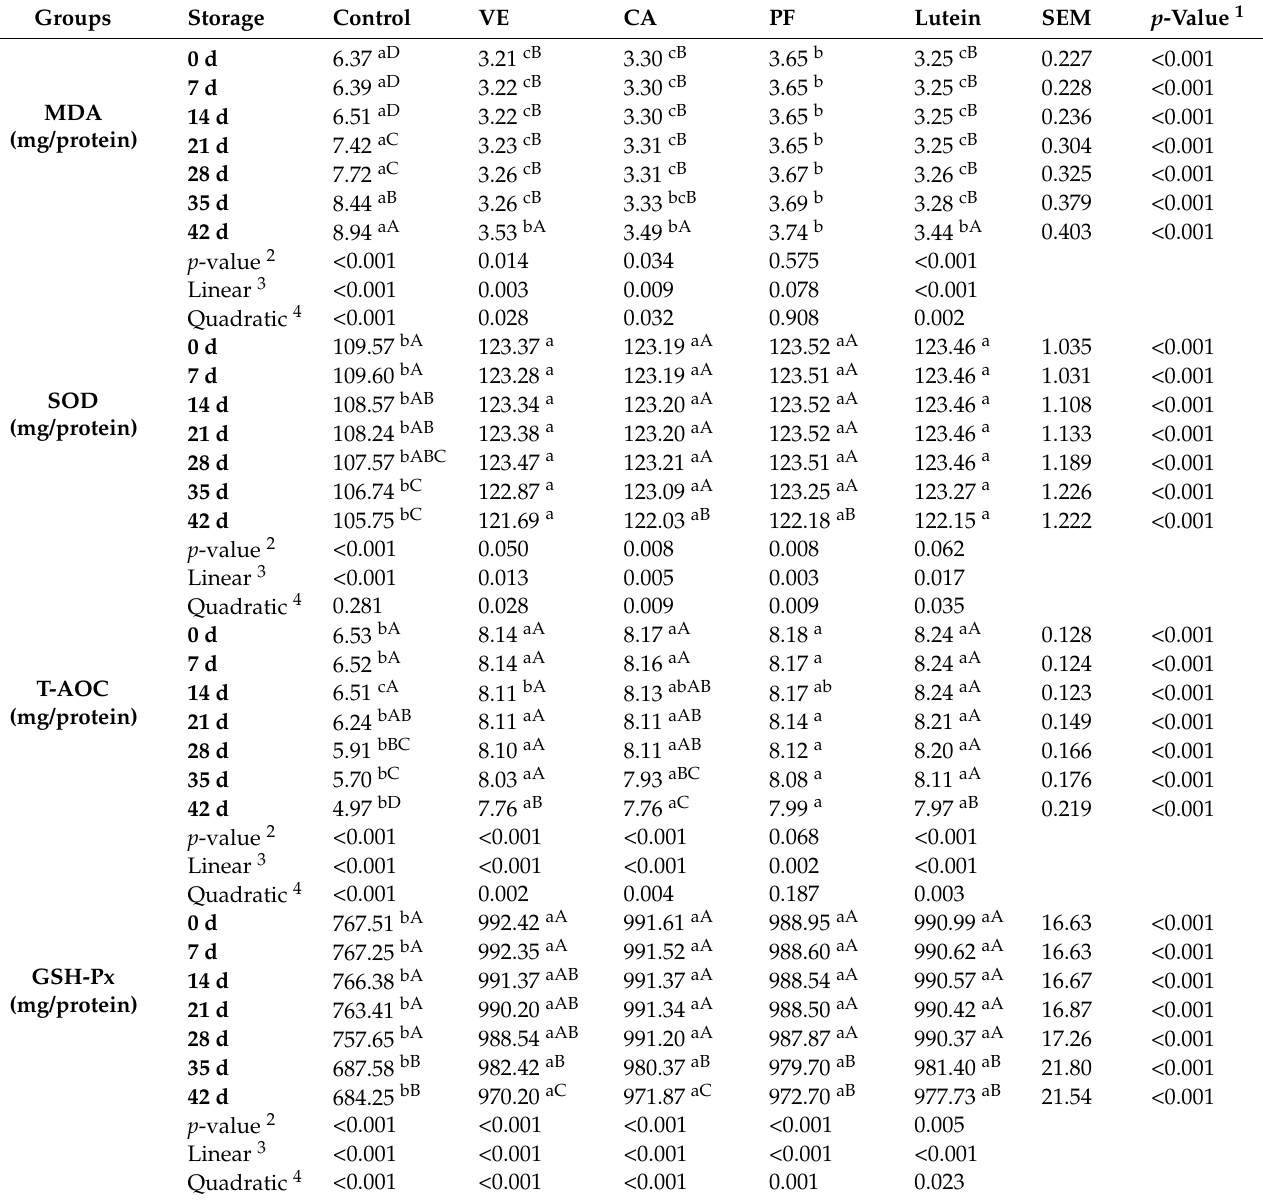
Table 5. The effect of different antioxidants on the egg oxidation parameters during